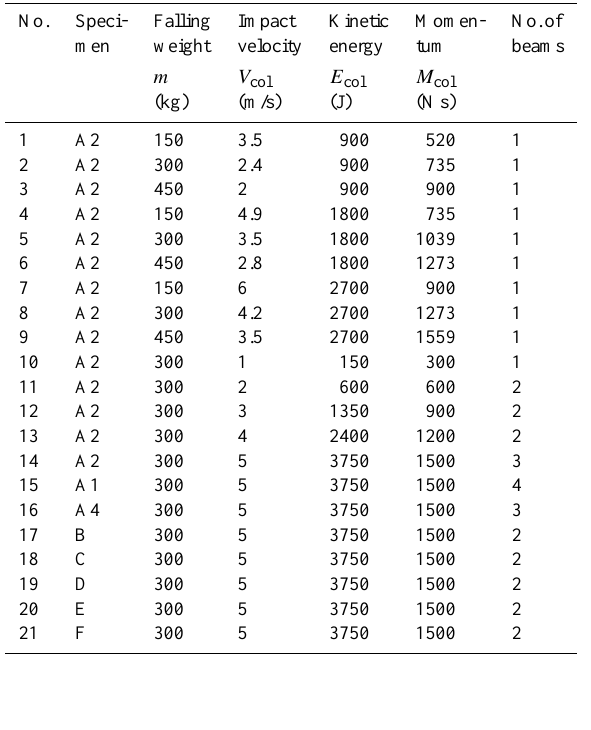
Table 2. Overview of impact tests.